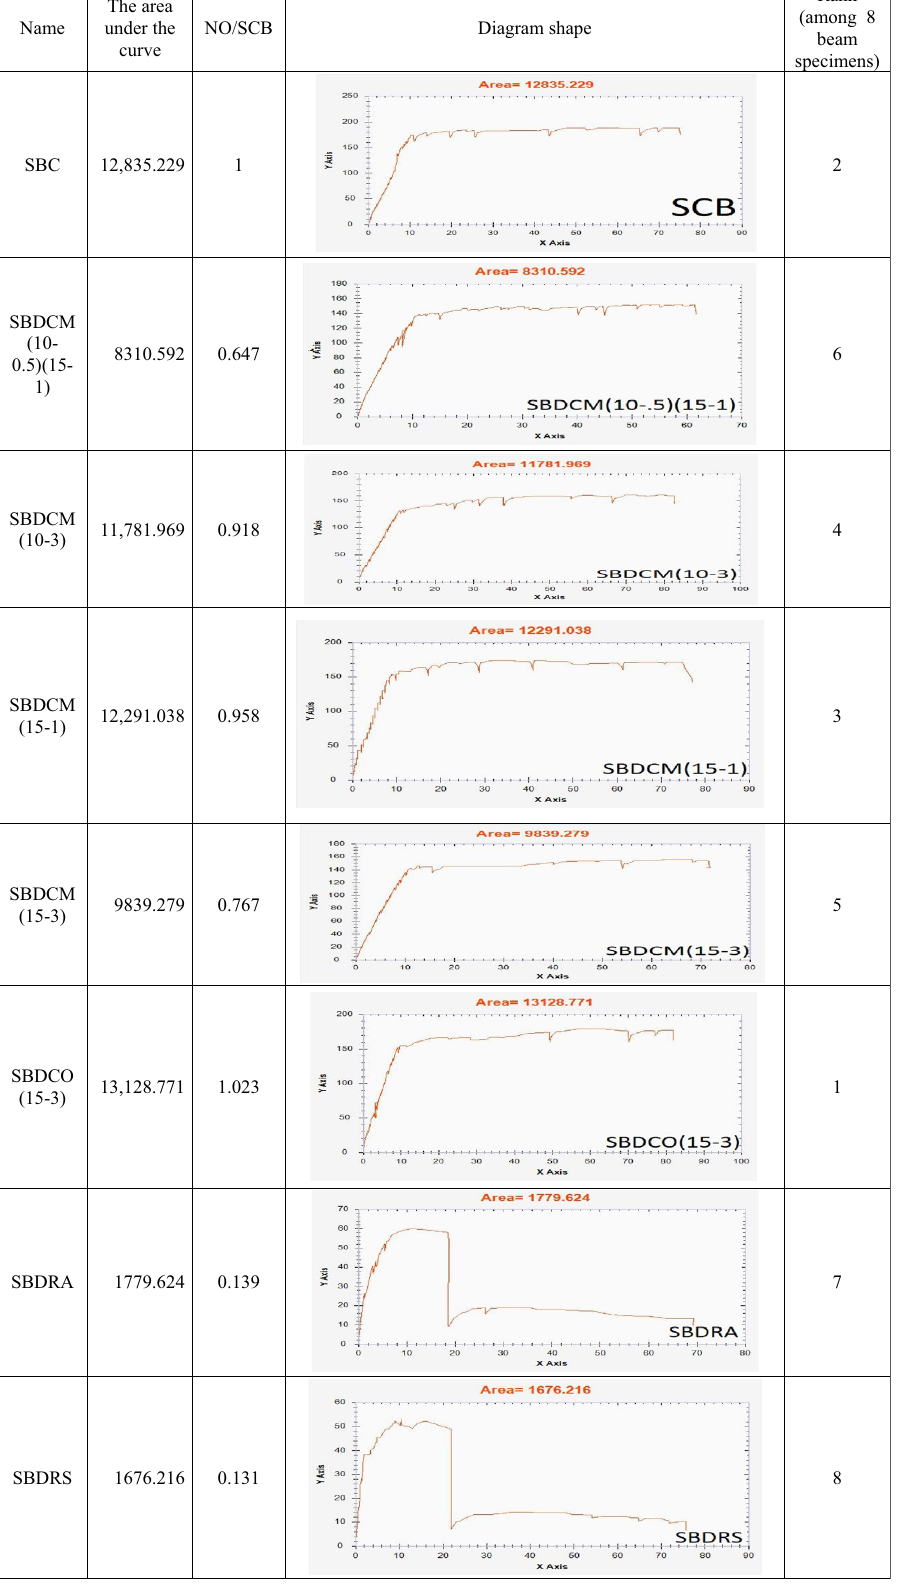
Table 3 The area under the curve for concrete